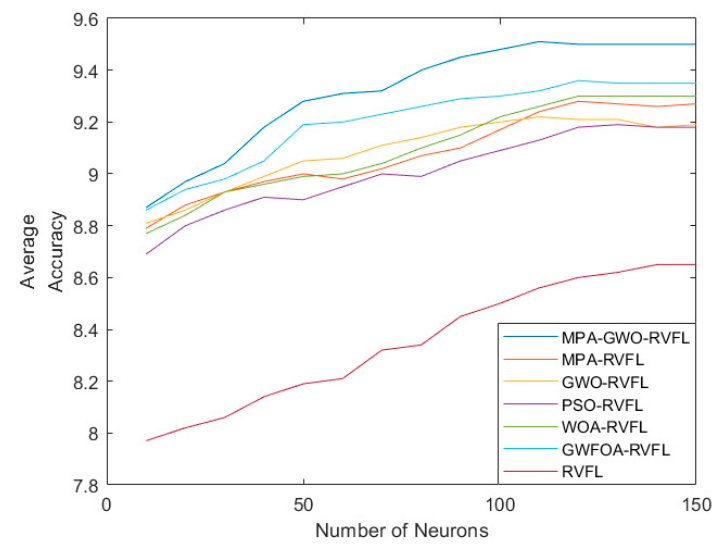
Figure 5. Influence of node number on prediction accuracy.